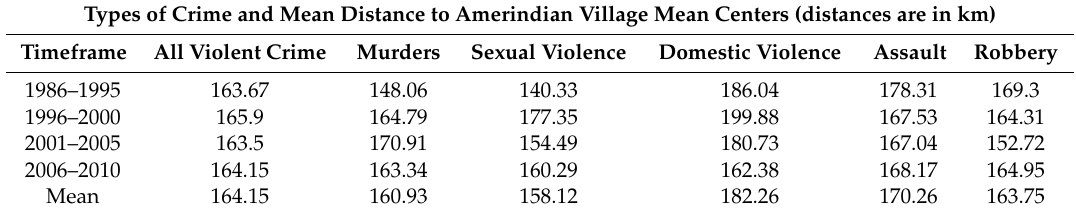
Table 2. The distance between the mean center of violent crimes and Amerindian villages’ mean center. Types of Crime and Mean Distance to Amerindian Village Mean Centers (distances are in